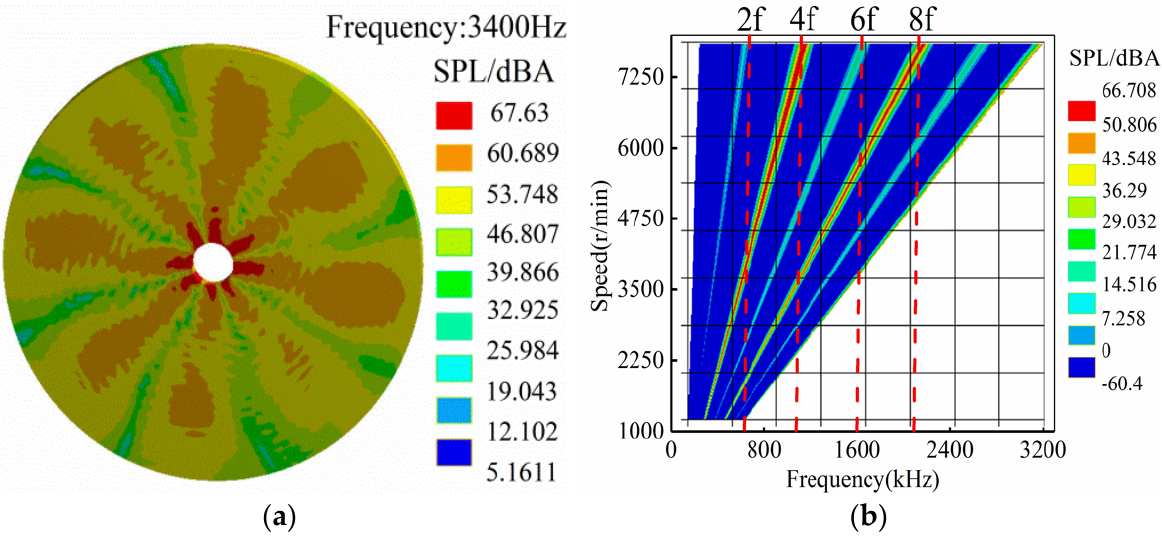
Figure 9. ( a ) SPL and noise distribution within 1 m of FeCo-based motor; ( b ) noise waterfall diagram of FeCo-based motor under load.